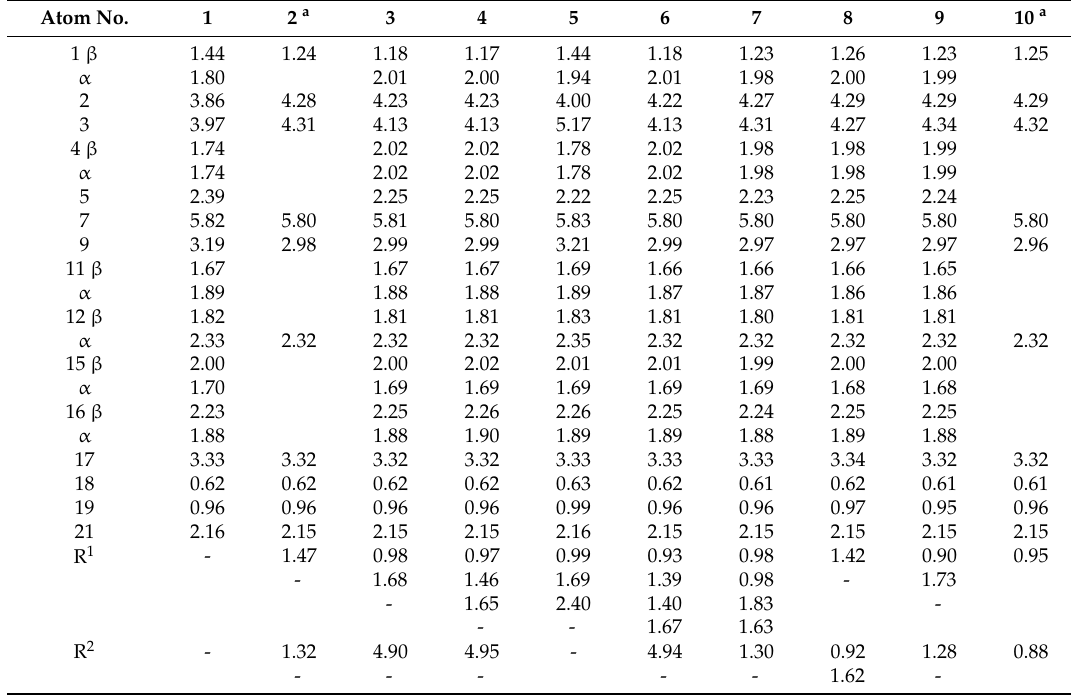
Table 1. 1 H-NMR chemical shifts of compounds 1 – 10 , in ppm, in MeOH- d 4 . Atom